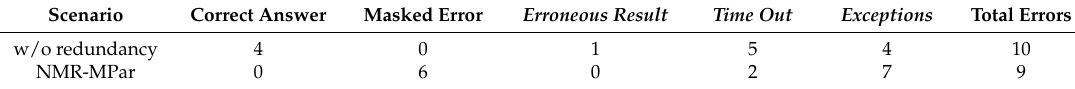
Table 7. SEE Sensitivity of the TSP solving the 17 cities problem.